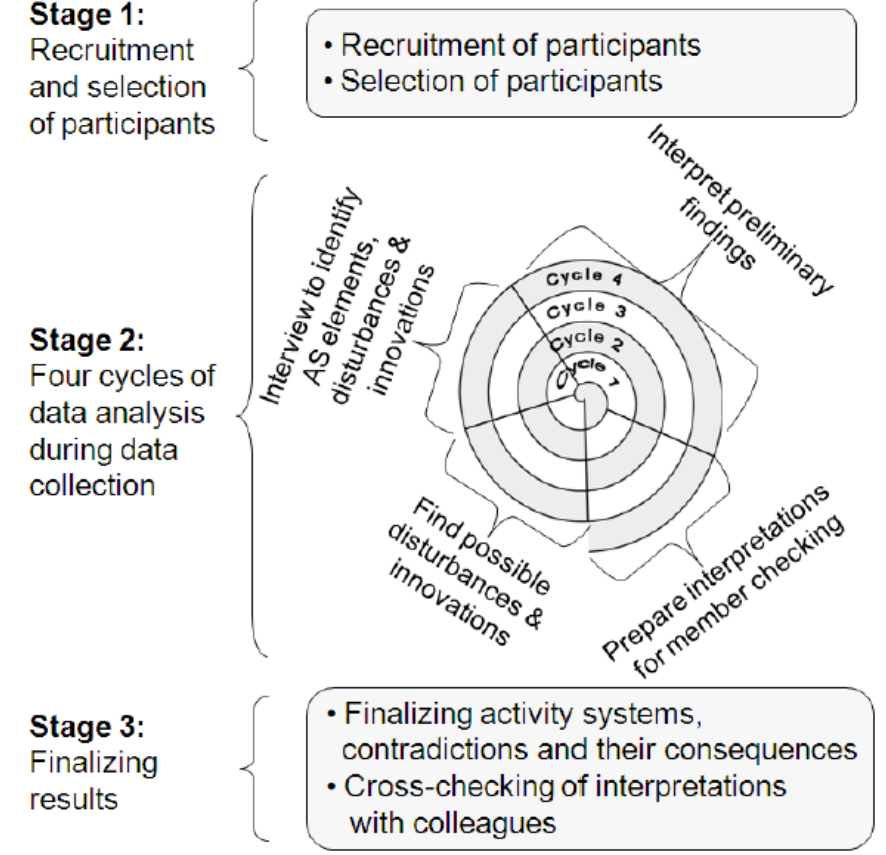
Figure 5. Three stages of data collection and